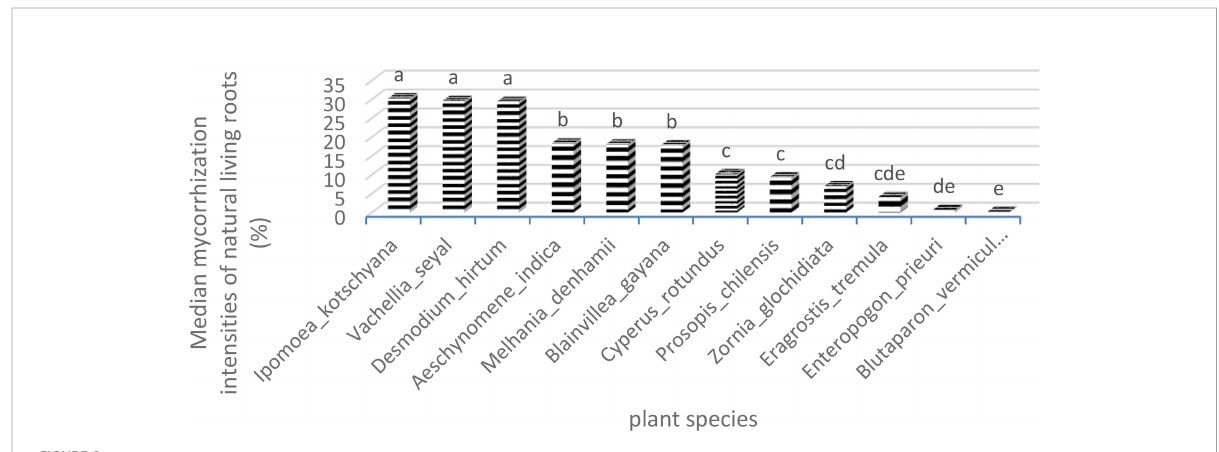
FIGURE 9 Intensities of mycorrhization of natural living roots. Means with identical letters are statistically equivalent at the 5% level